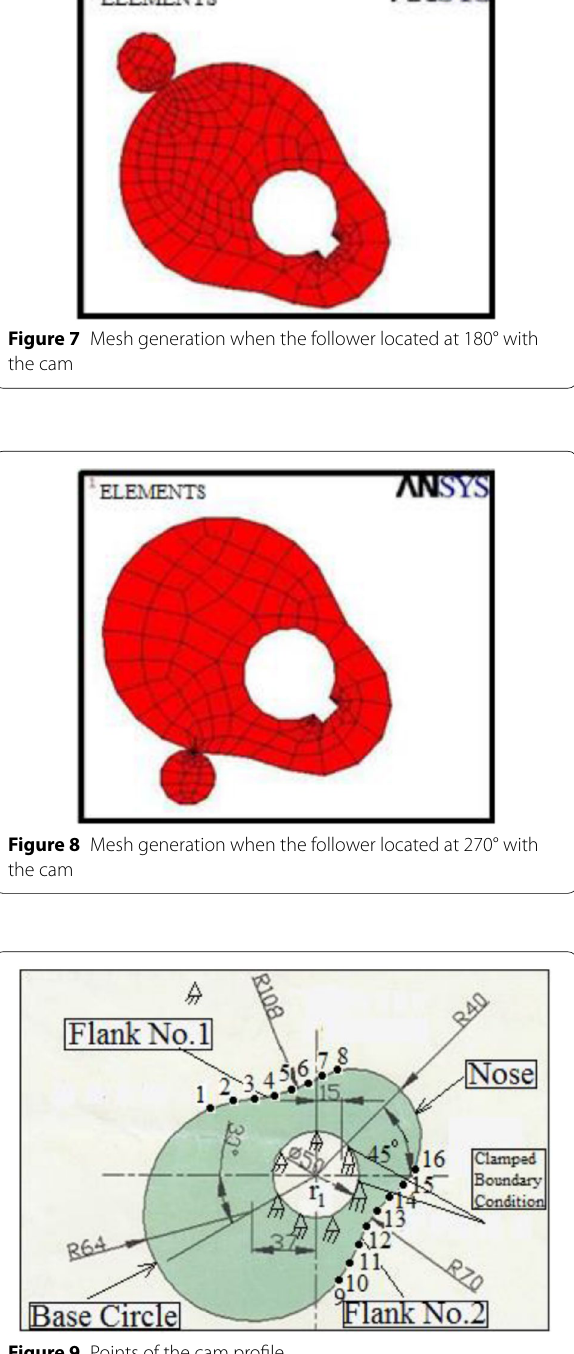
Figure 9 Points of the cam